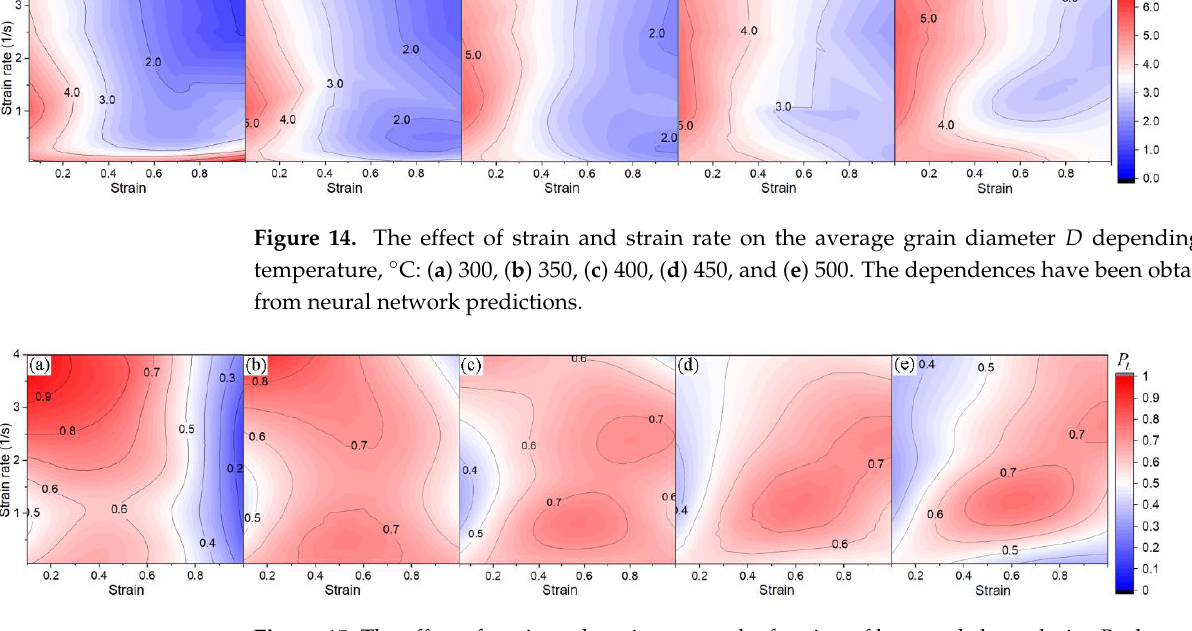
Figure 16. The effect of strain and strain rate on the density of low-angle boundaries